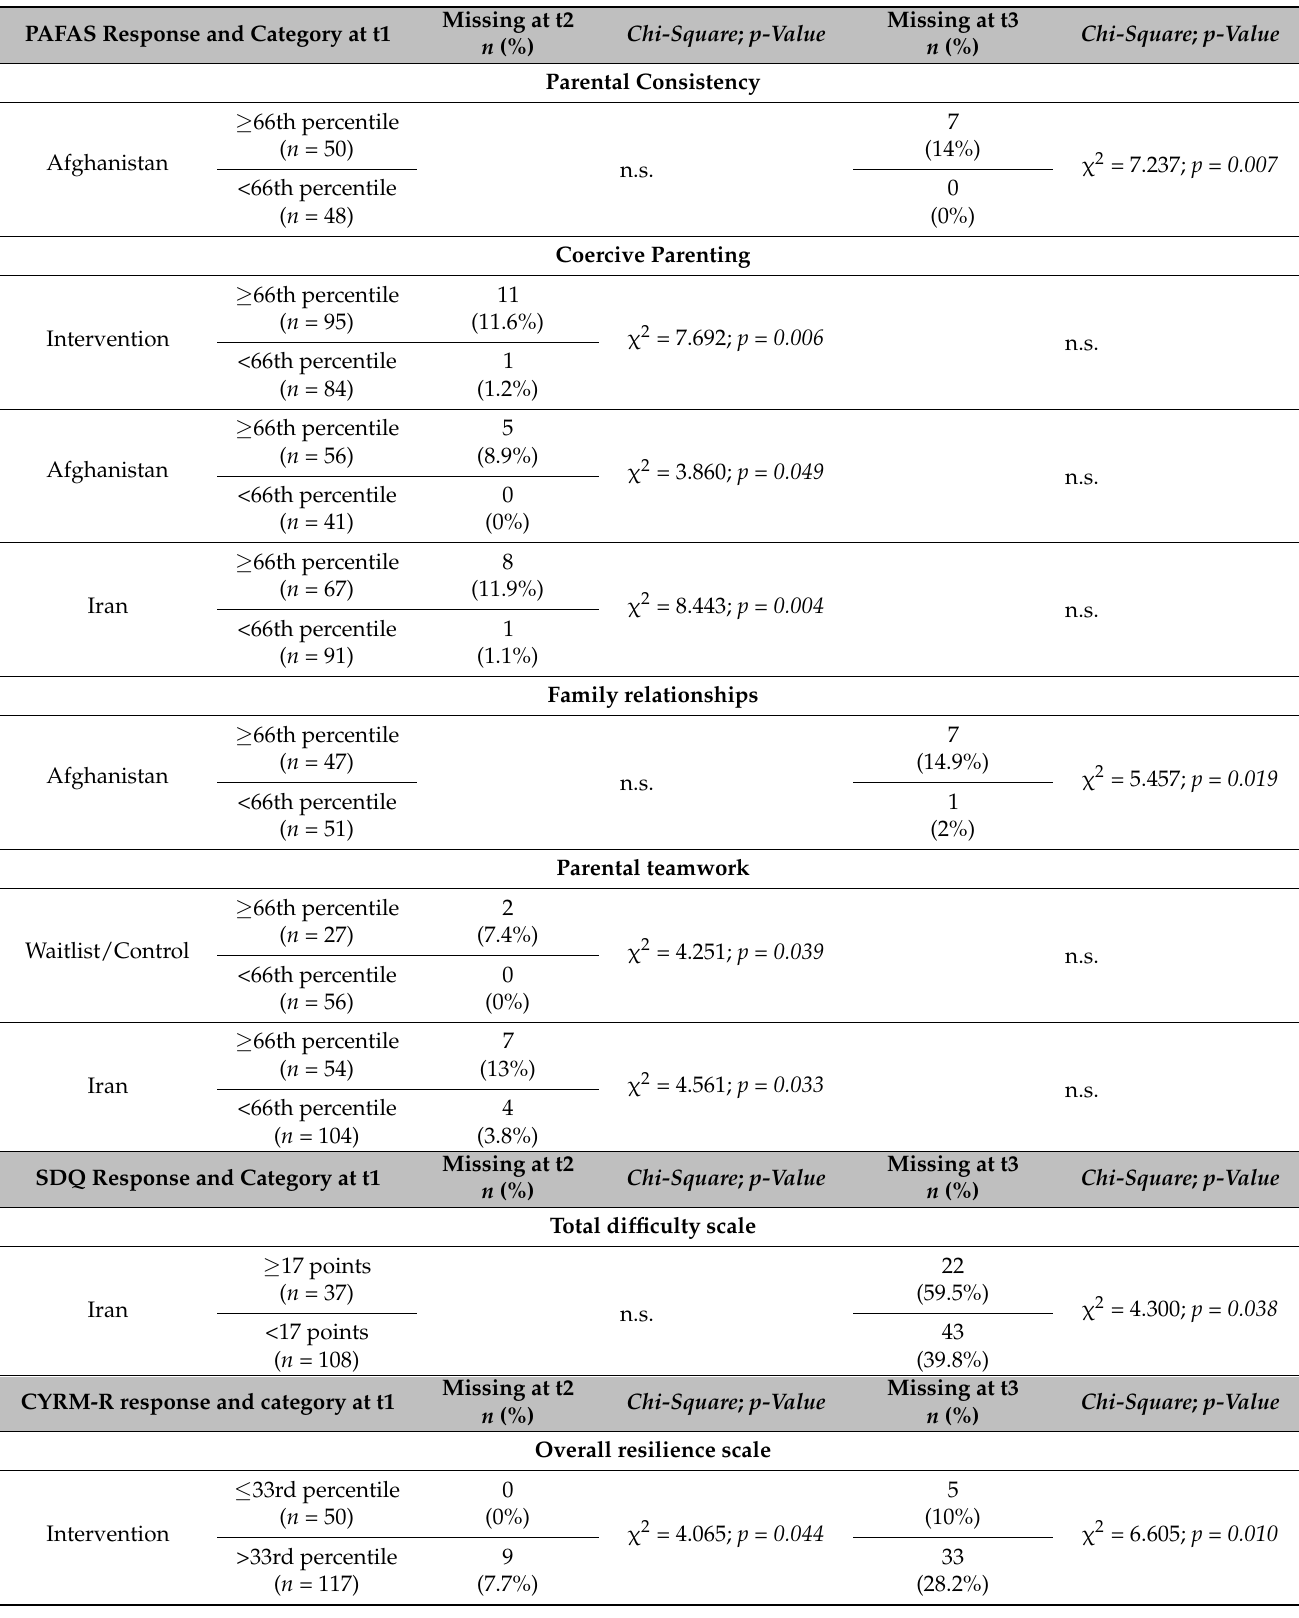
Table A2. Missing data in families divided by scores at time 1; only significant results are shown in families divided by their intervention group and/or country of origin; n.s.: not